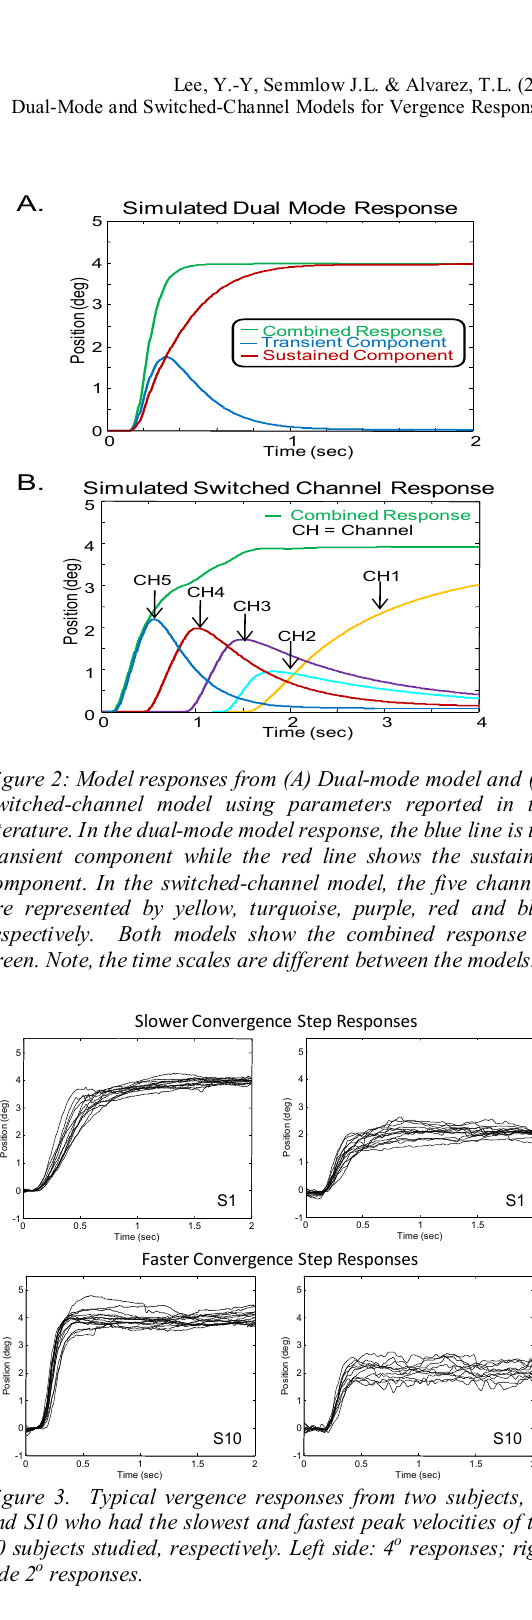
Figure 3. Typical vergence responses from two subjects, S1 and S10 who had the slowest and fastest peak velocities of the 10 subjects studied, respectively. Left side: 4 o responses; right side 2 o